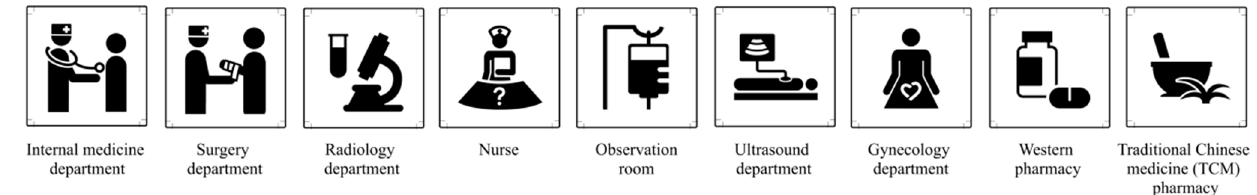
Figure 5. The designs of healthcare wayfinding signs in this study.